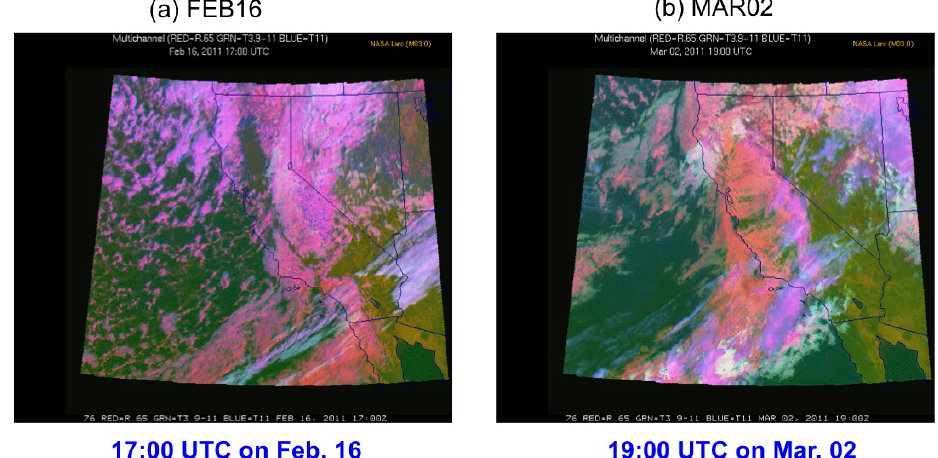
Fig. 1. Multi-channel RGB images from GOES-11 for (a) FEB16 and (b) MAR02. Images are from the VISST Cloud Product. In the figures, red was produced using the visible (0.65µm) reflectance (R_65). Green was produced using the differences between the 3.9-µm and 11- µm brightness temperatures (T3.9–11). Blue was produced using the 11-µm brightness temperature (T11). This color combination allows discrimination between low, middle and high clouds. The peach-colored areas indicate low clouds, like stratus; the bright pink to white areas indicate high ice clouds like cirrus; and the red areas indicate mid-level clouds. There are some dark pink, almost red areas in Nevada and over the Sierra Nevada, which are